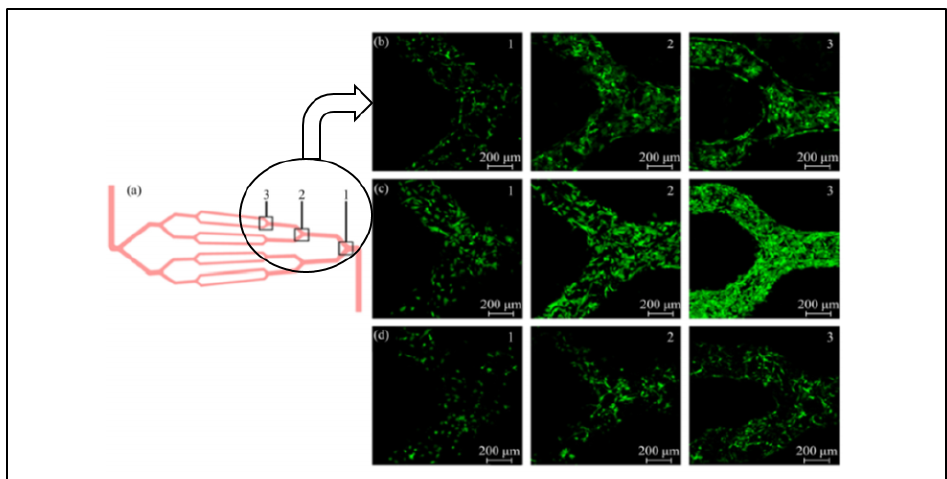
Figure 6. Culture of the cells in a vessel-like network ( a ). Model predefined microchannels, ( b – d ) phase images of cell morphology inside three-level channels after cultivation for four days, seven days and 14 days [113]. Reprinted by permission of springer Nature. Copyright © 2016 by Springer Nature.